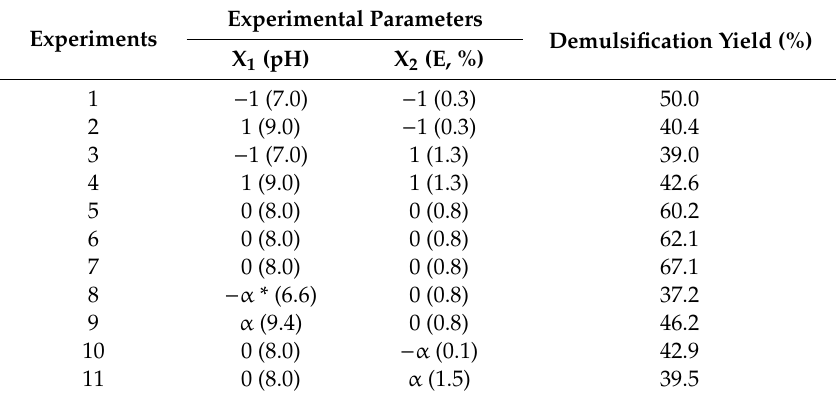
Table 3. E ff ects of pH and amount of enzyme on the enzymatic demulsification of the cream. Experiments